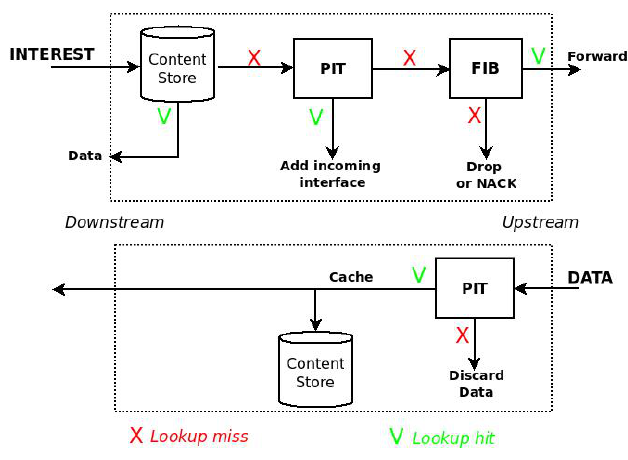
Figure 1. Forwarding process in